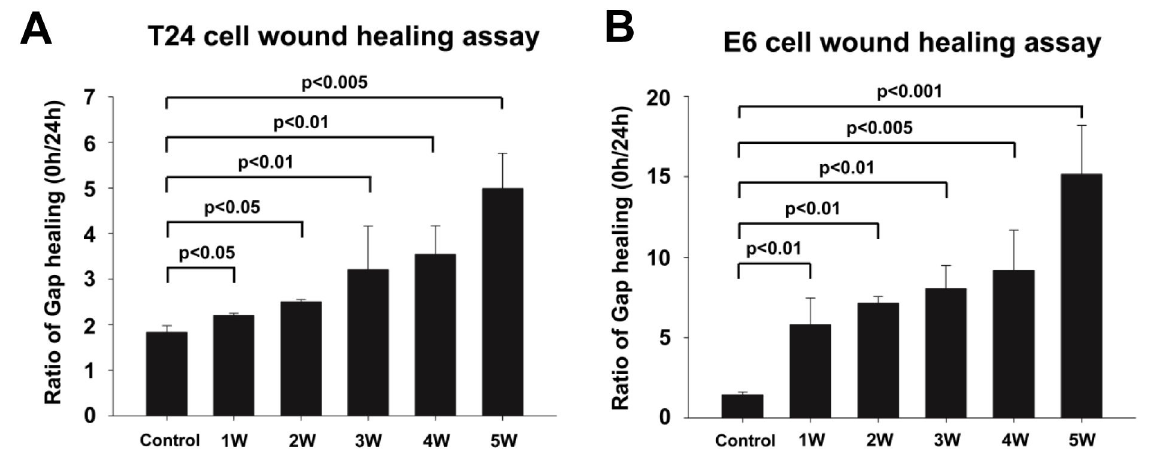
Figure 2. Hydronephrotic urine promoted the migratory capability of T24 cells and E6 cells. A wound healing assay was used to assess the migratory capability of T24 cells and E6 cells. (A, B) T24 cells and E6 cells were cultured in hydronephrotic urine from 1 to 5 weeks after UUO for 24 hrs. The ratio of gap healing was defined as the gap distance at 0h divided by the gap distance at 24h (0h/24h) (Control: without hydronephrotic urine treatment).